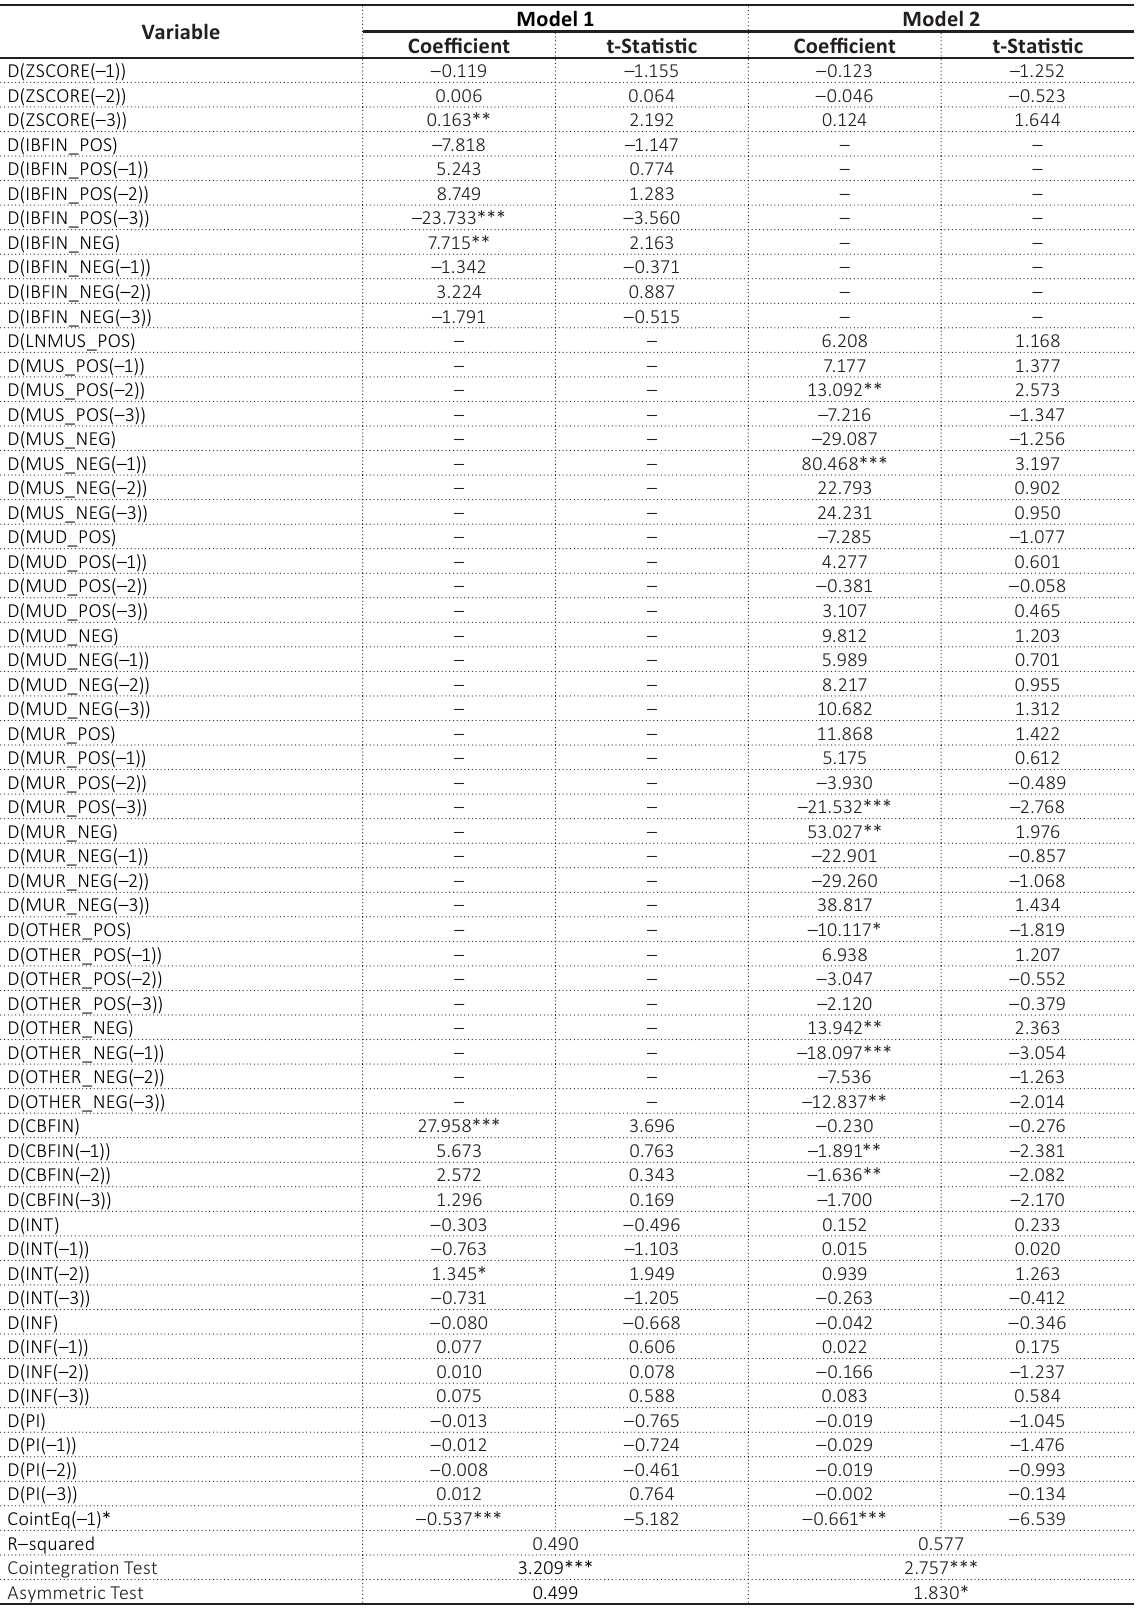
Table 4. Results of short-run